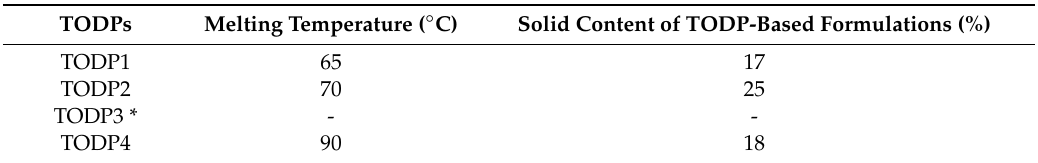
Table 1. Melting temperature of tall oil distillation products (TODPs) and concentration of the TODP-based formulations in furfuryl